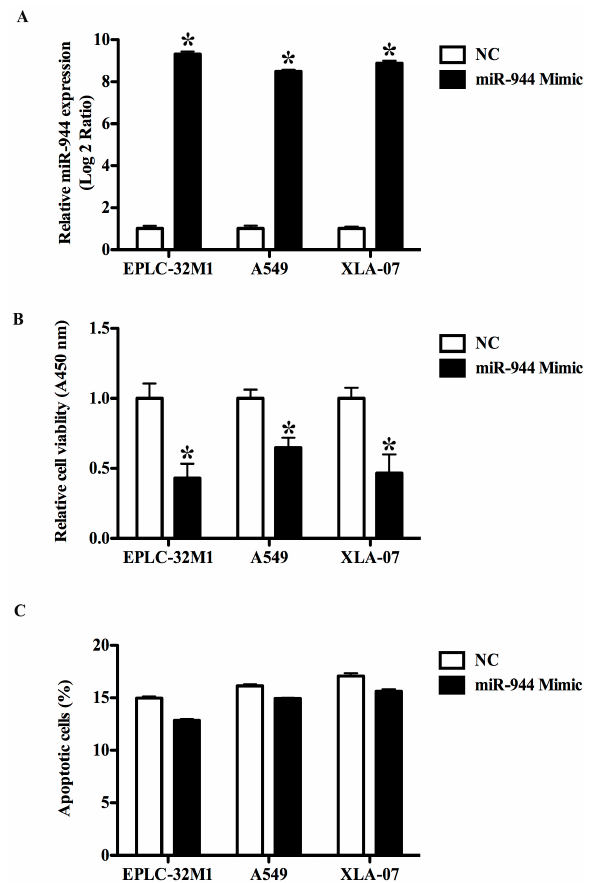
Figure 3. Effects of the ectopic miR-944 expression on the growth of cultured NSCLC cells. ( A ) Relative expression levels of miR-944 in EPLC-32M1, A549 and XLA-07 with or without miR-944 mimic transfection. The results of the cell proliferation assay ( B ) and apoptosis assay ( C ) in the three cell lines with or without miR-944 mimic transfection. The significance was evaluated by t -test, * p < 0.05.